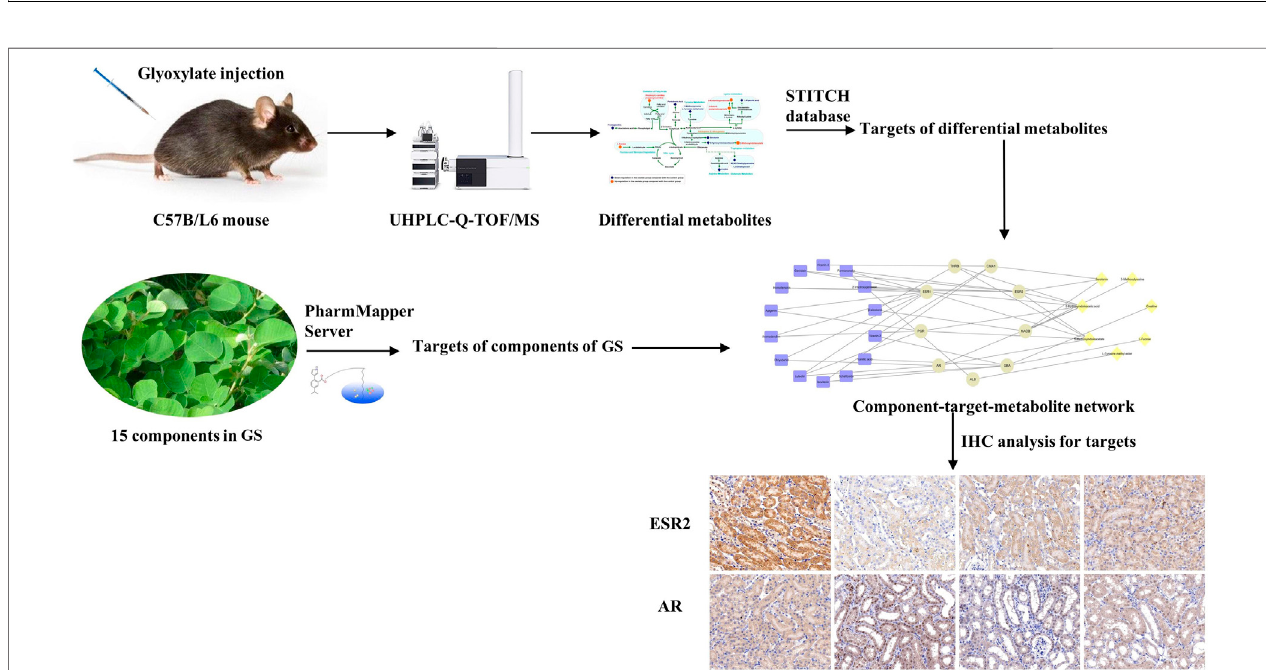
FIGURE 9 | Roadmap of this study.